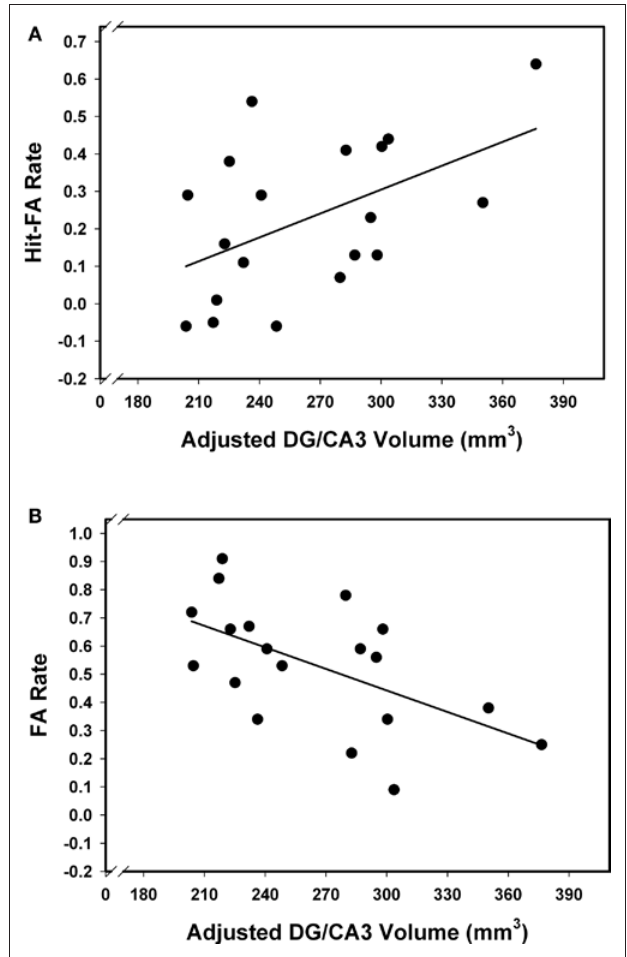
Figure 4 | relation between memory performance and CA3–4&Dg volume. Larger CA3–4&DG is associated with better memory performance (A) , and in particular, lower FA rate (B)